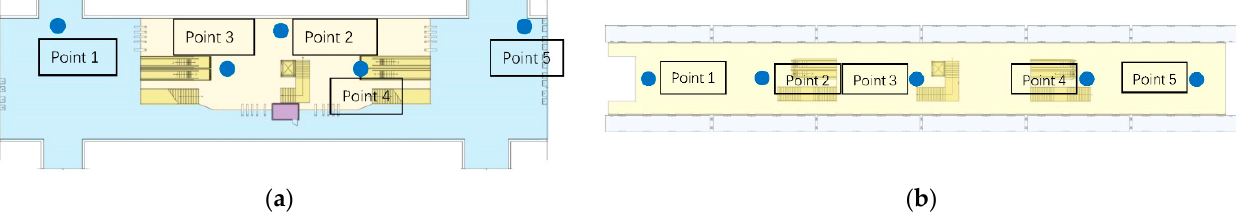
Figure 22. Arrangement of measurement points at two floors: ( a ) Concourse floor; ( b ) Platform floor. Table 5. Actual PM2.5 Concentration Measurement Results (Unit: μ g/m 3 ).